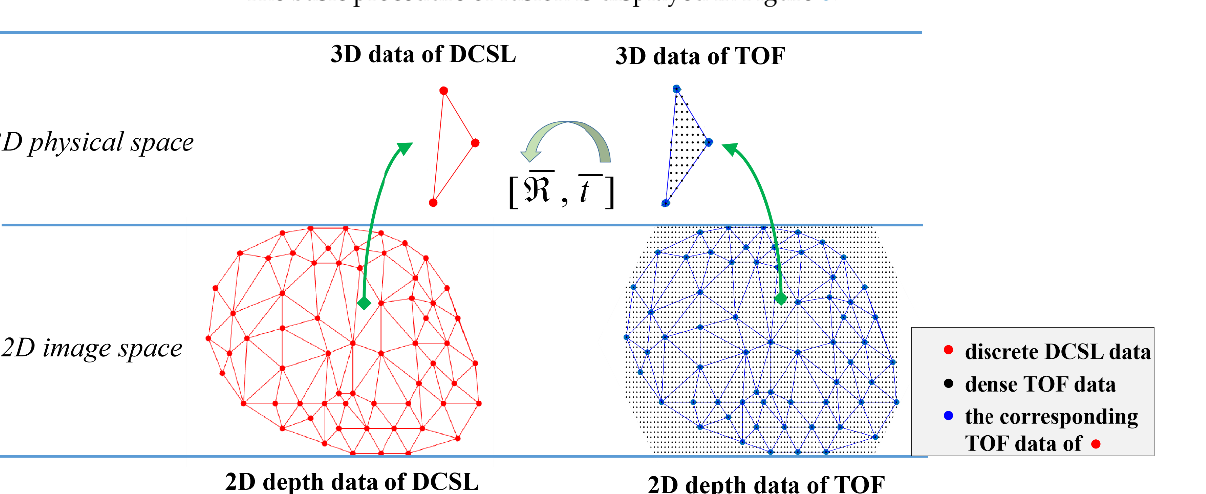
Figure 6. Subregional fusion of TOF and DCSL data based on triangular topology.